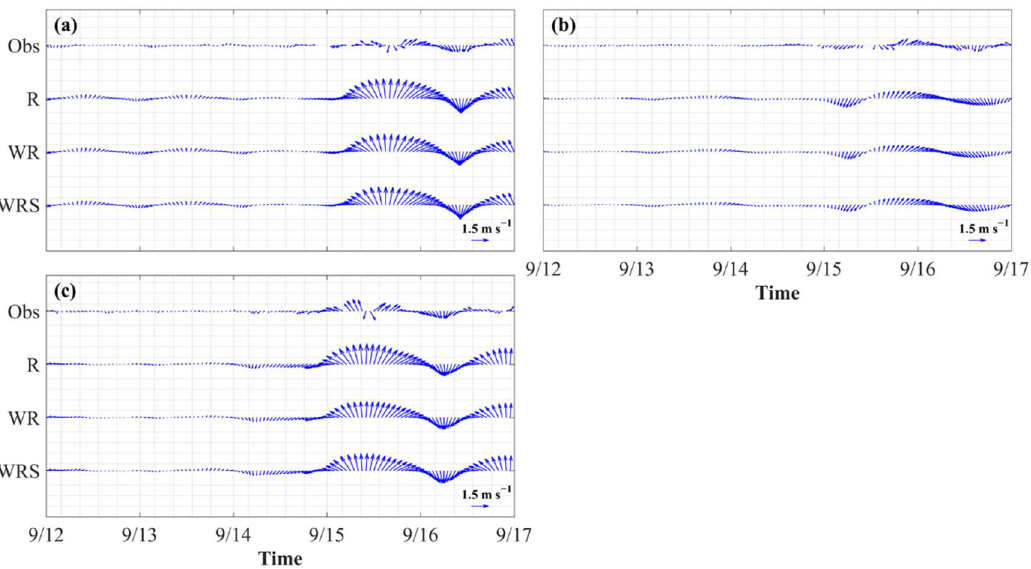
Figure 11. Comparison of observed and simulated ocean surface current (m s − 1 ) at ( a ) Buoy 1; ( b ) Buoy 2; and ( c ) Buoy 4.